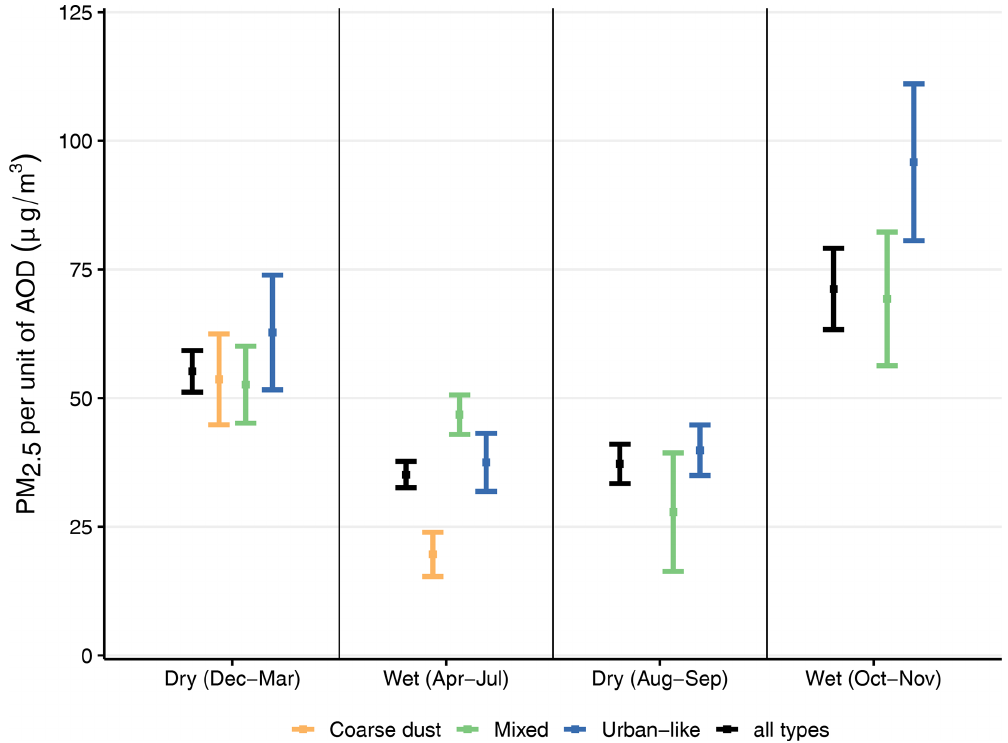
Figure 8. Ratio of PM 2 . 5 to AOD for each of the aerosol types during the long dry (December–March) and long wet (April–June) seasons and the short dry (August–September) and short wet (October–November) seasons. Data are collected in Abidjan and Cotonou from 2015 to